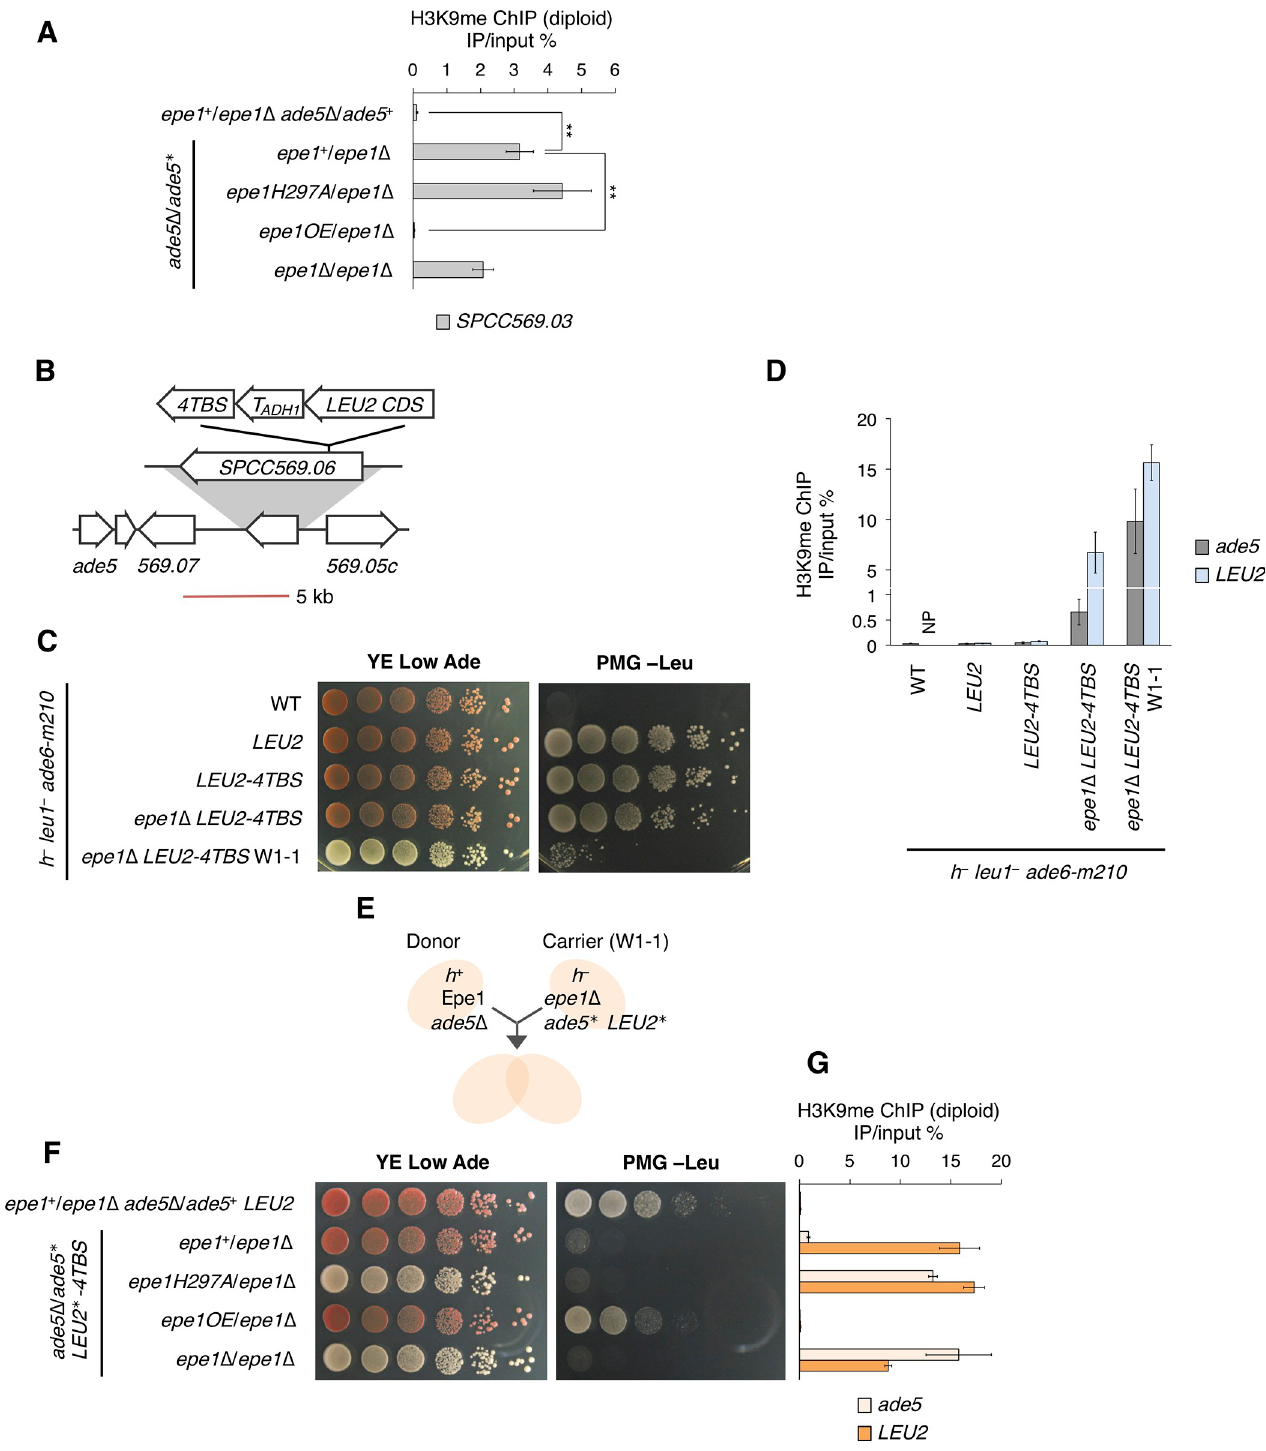
Fig 5. JmjC-mediated incomplete suppression of ectopic heterochromatin provides metastable epigenetic variation. (A) ChIP-qPCR analysis of H3K9me at SPCC569 . 03 in diploid cells. The indicated strains provided biallelic signals. �� p < 0.05 (two-tailed Student’s t -test). The strains used were the same as those in Fig 4C and 4D. (B) Schematic diagram of the LEU2-4TBS invasion system. Transcription of the coding sequence of S . cerevisiae LEU2 was initiated by the promoter of SPCC569 . 06 and terminated by the S . cerevisiae ADH1 terminator. 4TBS was placed after the terminator. Bar, 5 kb. (C) Ten-fold serial dilution assay of the strain harboring 4TBS -induced heterochromatin shown on adenine-limited and PMG − Leu media. (D) ChIP-qPCR analysis of H3K9me at ade5